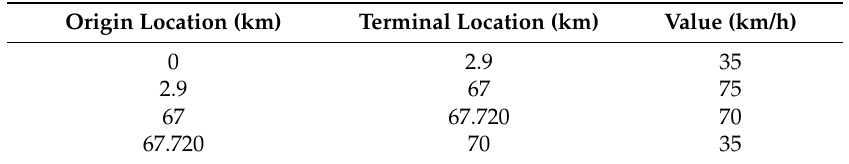
Table 2. Line speed limits.